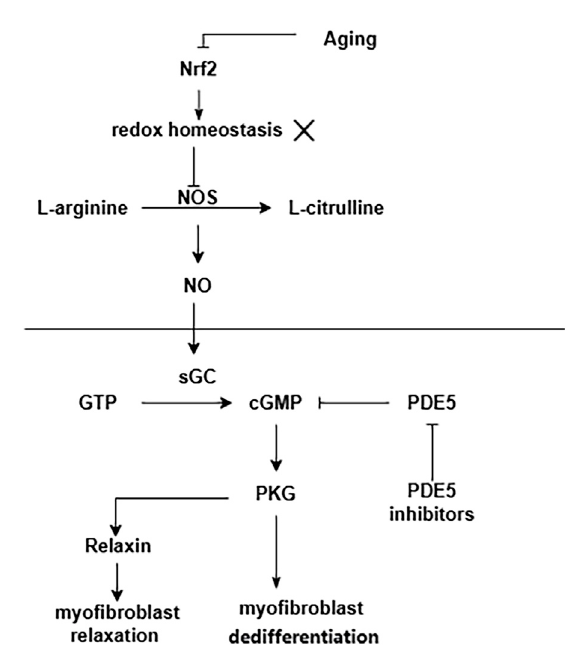
FIGURE 4 NO/sGC-cGMP pathway in pulmonary fi brosis. Aging leads to a decrease in the antioxidant capacity of Nrf2. This pro-oxidant shift results in NOS decoupling and a concurrent decrease in NO signaling and PKG